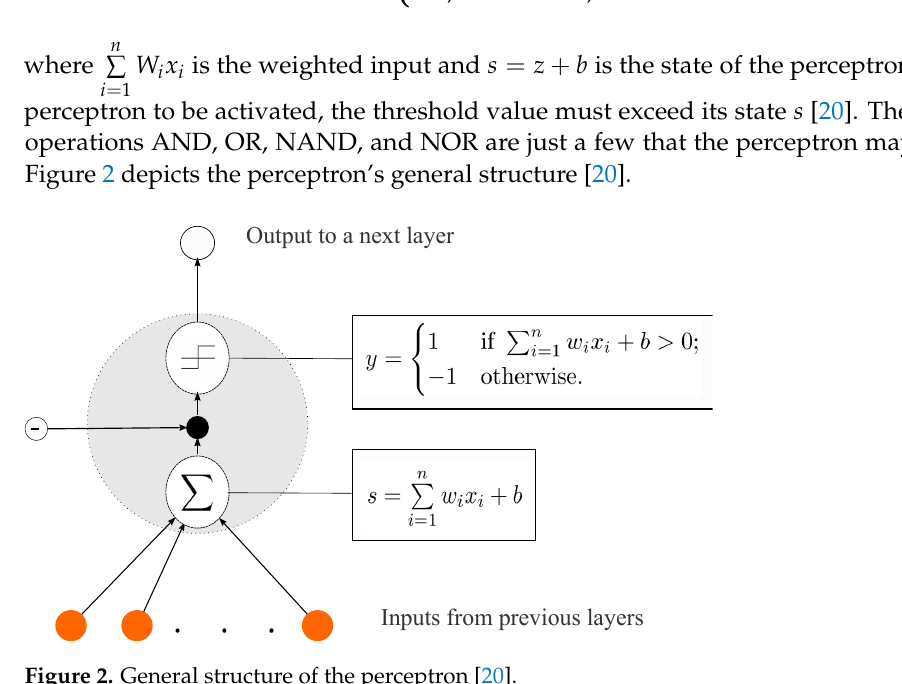
Figure 2. General structure of the perceptron